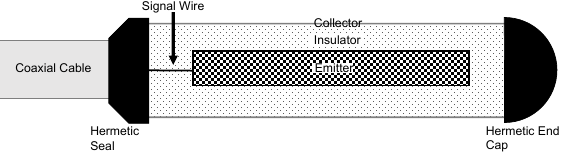
Fig. 1. Diagram of an SPND. It is expected that neutrons will be captured or scattered within the emitter (checked region), resulting in nuclear or ionization reactions that produce electrons with energies high enough that they can escape the emitter and travel through the insulator (white dotted region) to the collector (gray